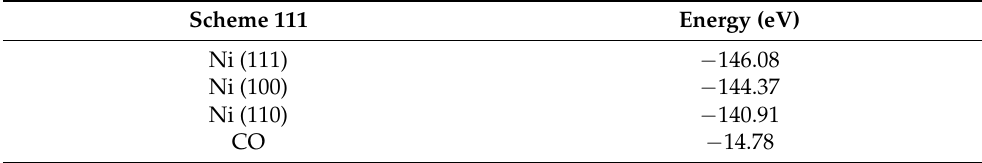
Figure 4. Four adsorption models of CO on Ni (110) crystal surface.